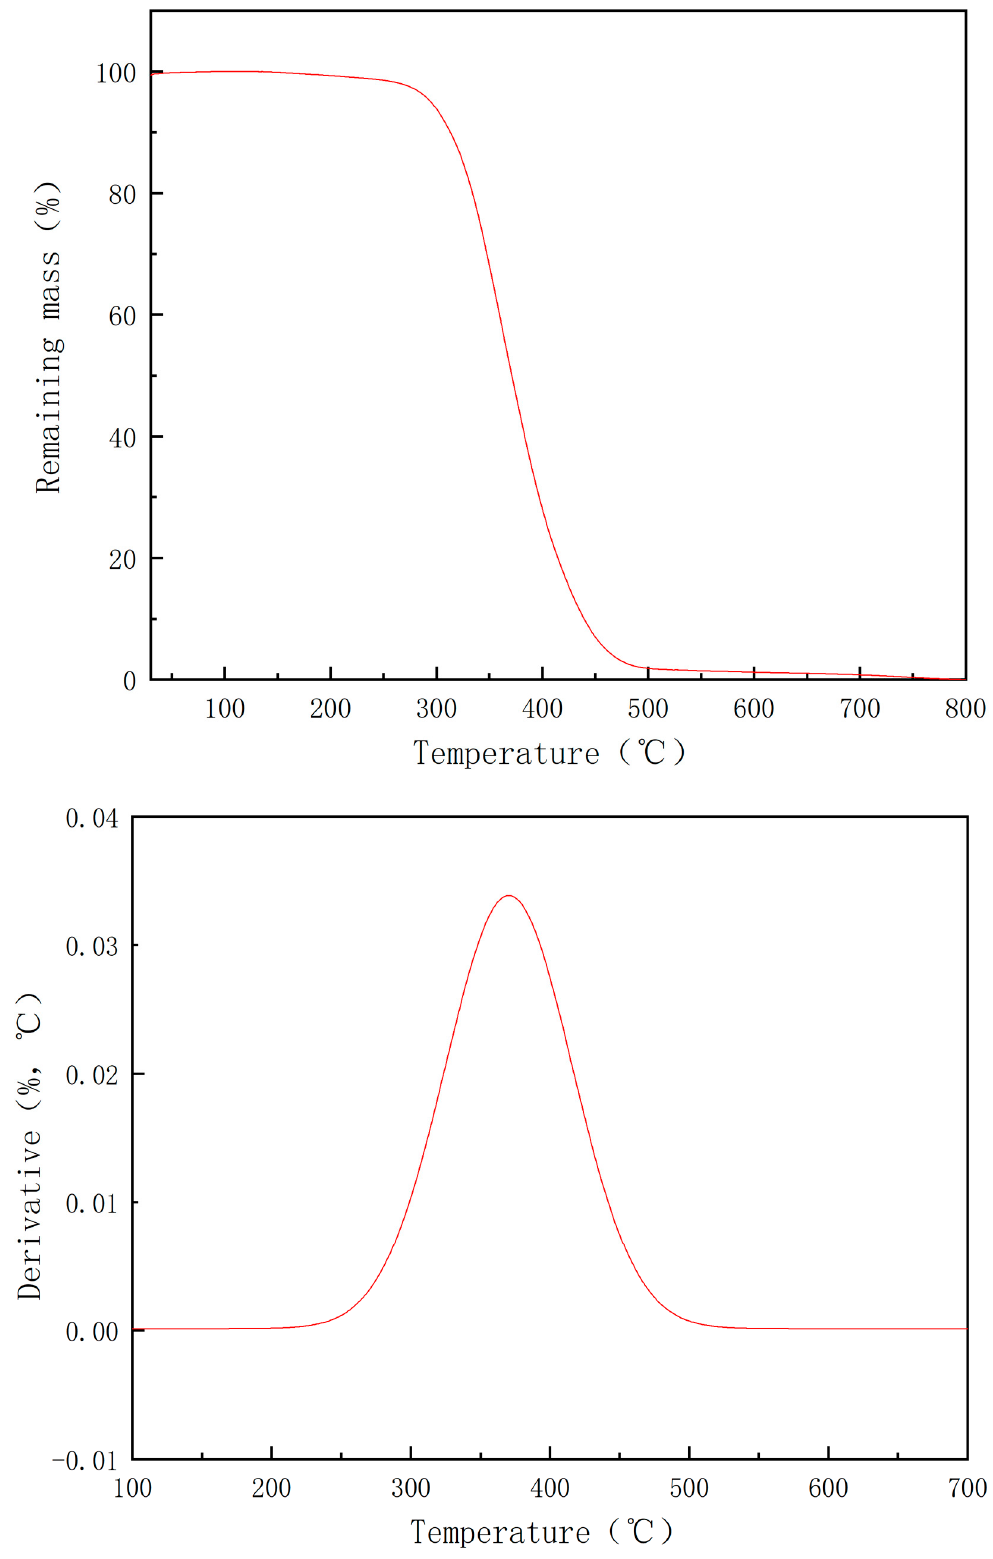
Figure 10. TG and DTG curves of the compound bis[(3-ethyl-3-methoxyoxetane)propyl]diphenylsilane.